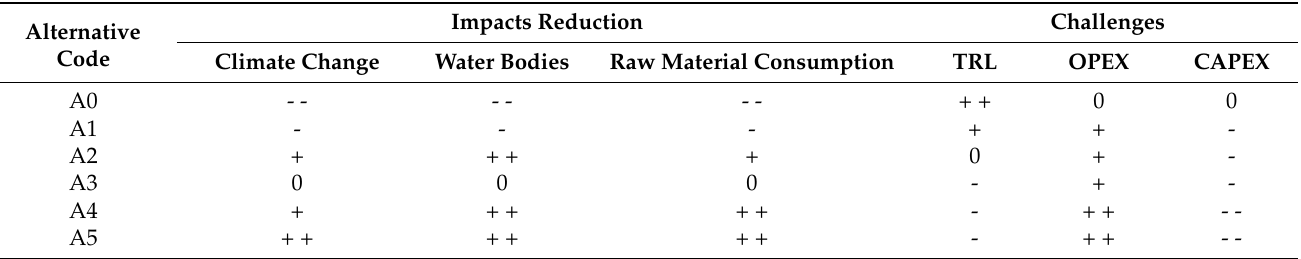
Table 4. Alternatives comparison under different